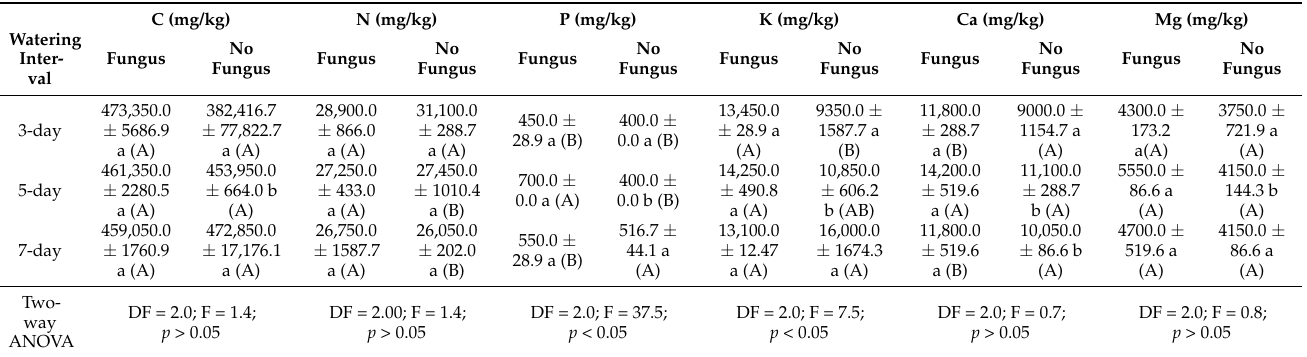
Table 2. Effects of water deficiency and the inoculation of growth medium with B. bassiana on the macronutrient content in bulbs of A. cepa .